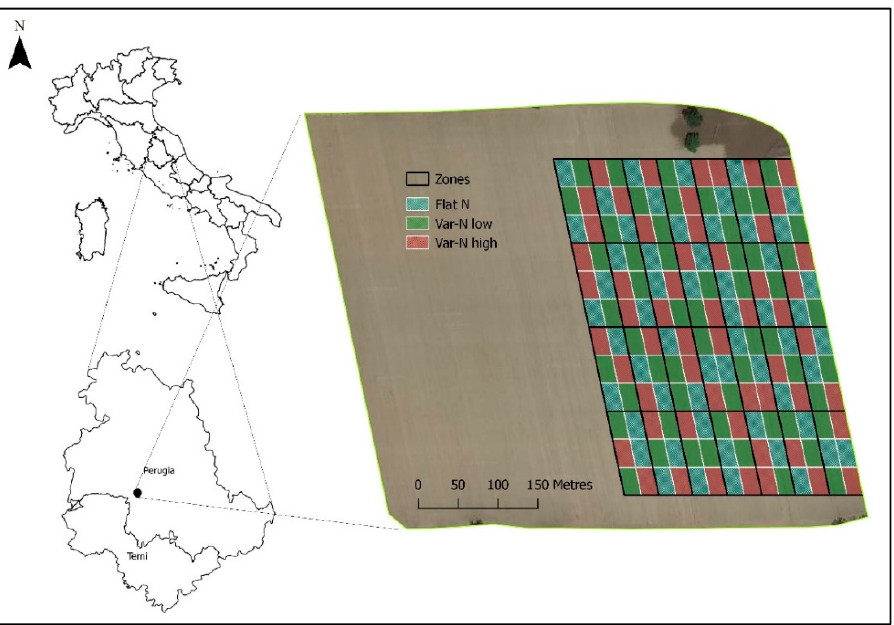
Figure 1. Geographical location of the study area and experimental layout. Flat-N (standard rate of 120 kg N ha − 1 ), Var-N-low (variable rate from 60 to 120 kg N ha − 1 ), Var-N-high (variable rate from 90 to 150 kg N ha − 1 ).